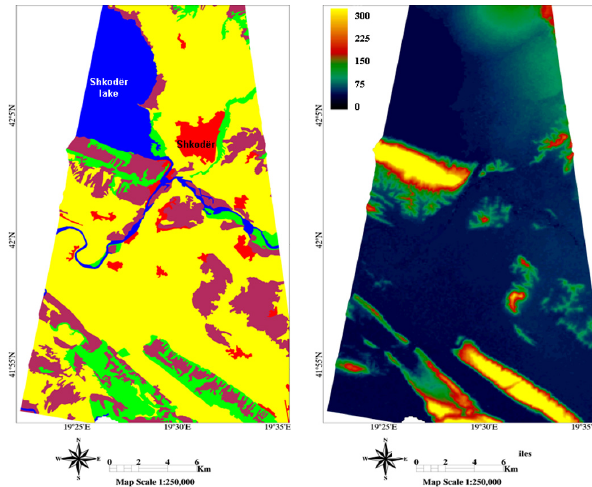
Fig. 4. Land Cover Map (left panel), derived from the Corine 2000 database, and Digital Elevation Model (right panel), derived from the SRTM mission, of the area of Shkod¨er. For the Land Cover Map, red: urban or built-up areas; green: bare soils; yellow: agri- cultural areas; maroon: forests; blue: water bodies. For the Digital Elevation Model the stretching is between 0m and 300m (see the colorbar). White areas correspond to no-data (regions not included in the analysis or areas not imaged by COSMO-SkyMed).